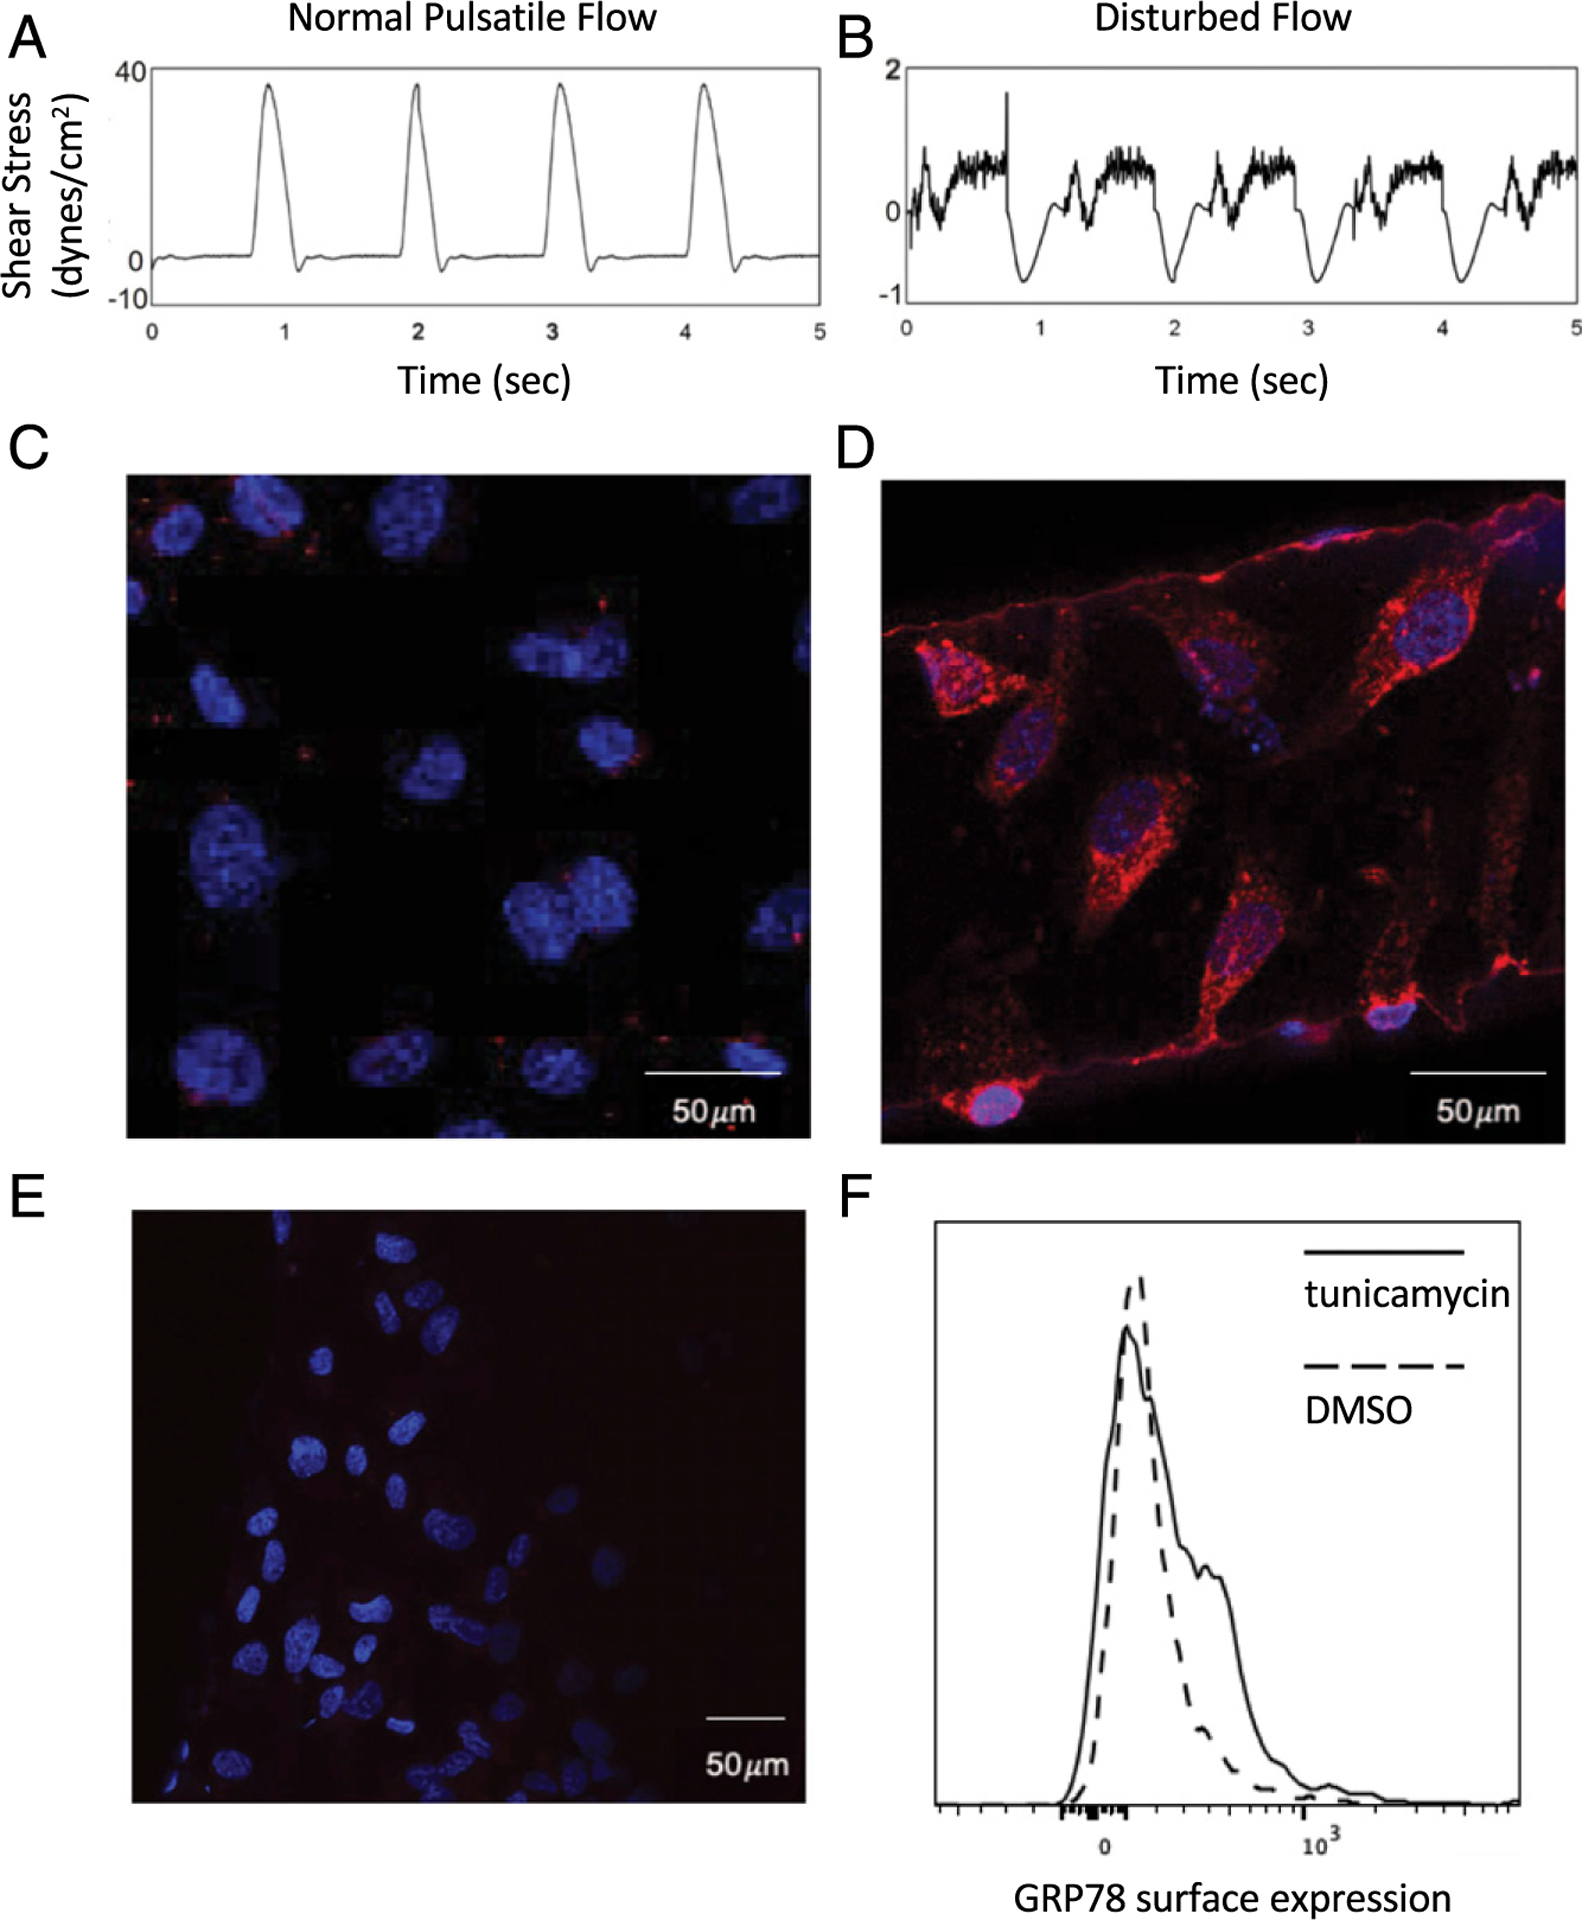
GRP78 expression on HAECs exposed to stresses of disturbed media flow and UPR induction.Shear stress patterns of normal pulsatile flow (A) or disturbed flow (B) generated inside the microfluidic ECCM chamber (27). Confocal microscopy showed that GRP78 (red stain) on HAECs grown under conditions of normal pulsatile flow was limited (C), in contrast to GRP78 expression on HAECs subjected to stressful conditions that mimic disturbed fluid flows (D) as seen in vascular niches where atherosclerotic plaques tend to develop. Blue stain denotes DAPI. (E) Normal goat IgG (isotype control) followed by the same secondary Abs as in (C) and (D) [anti-goat F(ab′)2-Texas Red] show the GRP78 staining of the latter is specific. (F) Tunicamycin (2.5 μg/ml) increased surface GRP78 expression on HAECs compared with DMSO (2.5 μg/ml) (carrier control) treatment.